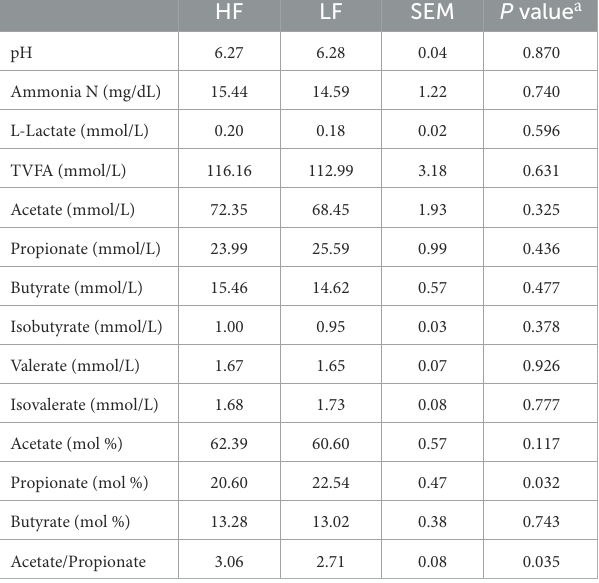
Supplementary Figure 2. The α -diversity of bacterial community showed no significant difference ( P > 0.05) between the groups (Supplementary Table 3). However, β -diversity exhibited a significant difference ( P = 0.040, PERMANOVA) between two groups (Figure 1A). There were no significant differences ( P > 0.05, Wilcoxon rank-sum test) in taxa between the two groups in the phylum or genus levels (Supplementary Figure